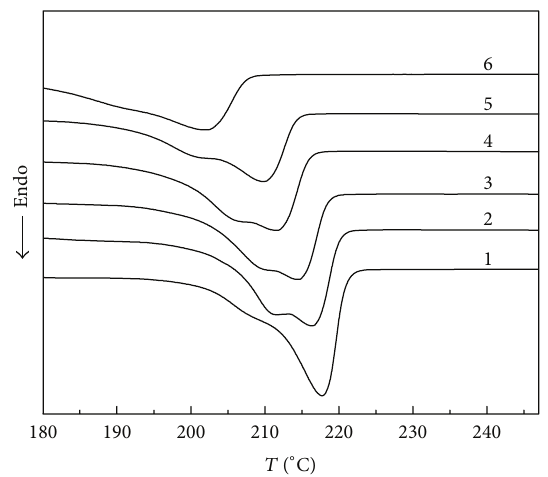
Figure 4: The second heating process of the PA6/LiCl composites with different LiCl content: (1) 0.0%; (2) 0.1%; (3) 0.3%; (4) 0.5%; (5) 1.0%; (6)